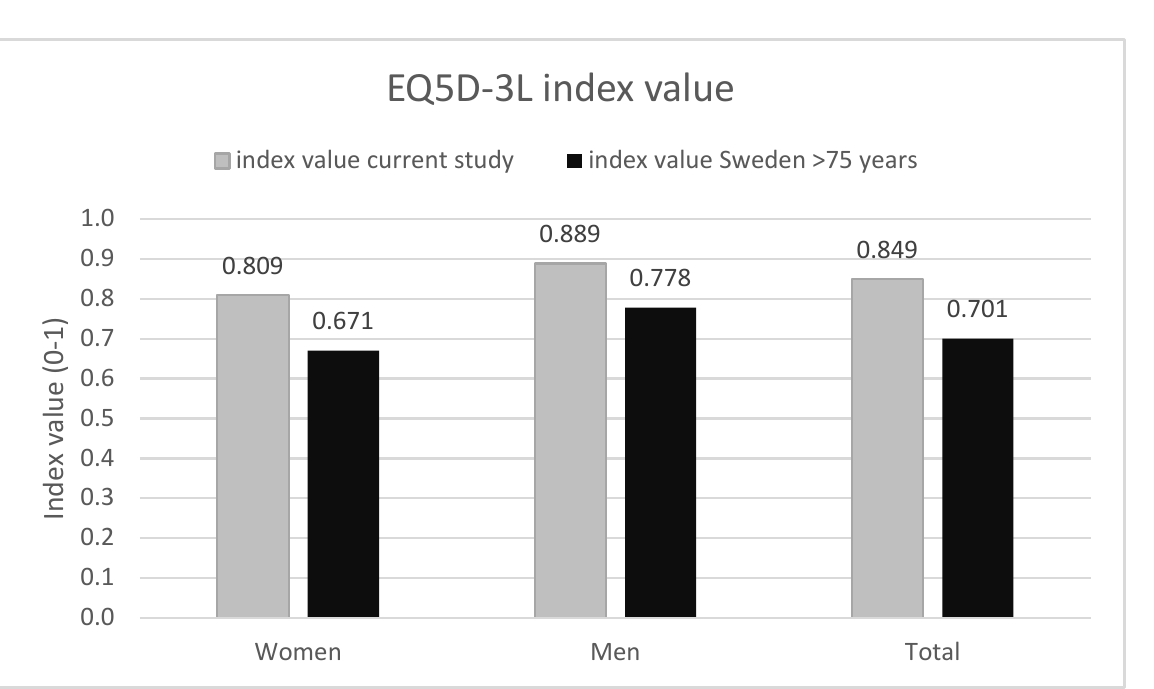
Figure 1. VAS from EQ5D-3L from this study and for an average Swedish population aged 75 and above [18]. The results are displayed in total and separated for men and women.